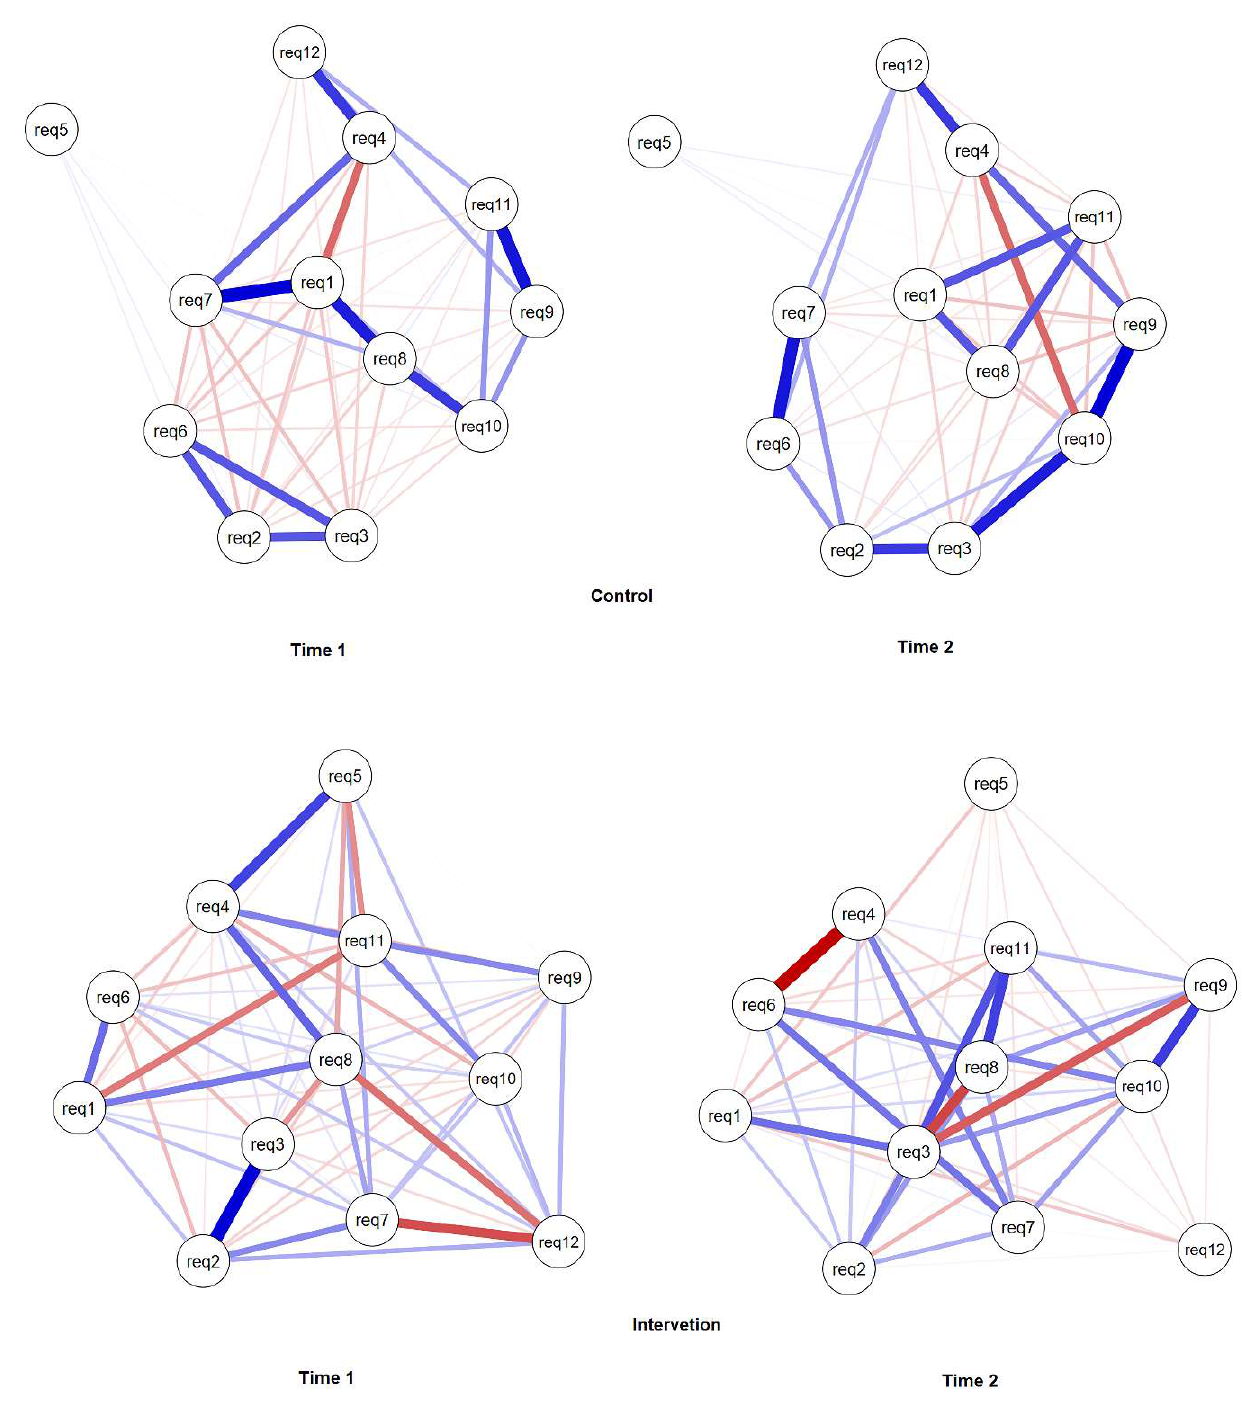
Figure 7. Estimated networks for ergonomics requirements according to body segments aspects, groups, and times.